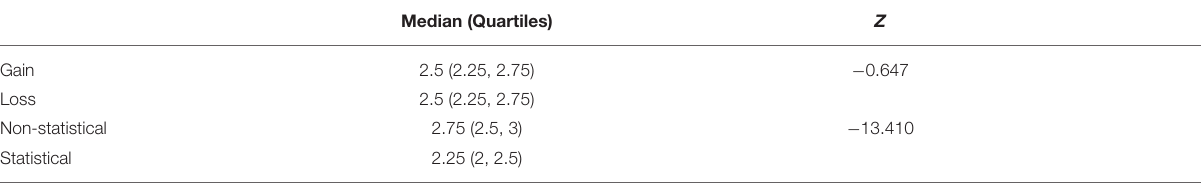
TABLE 3 | Wilcoxon signed-rank test for testing persuasive effects ( n = 918).